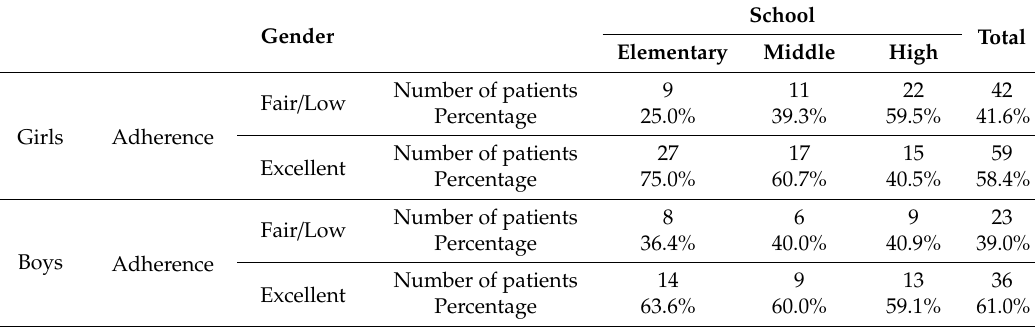
Table 5. Di ff erence in diet adherence between boys and girls throughout the education